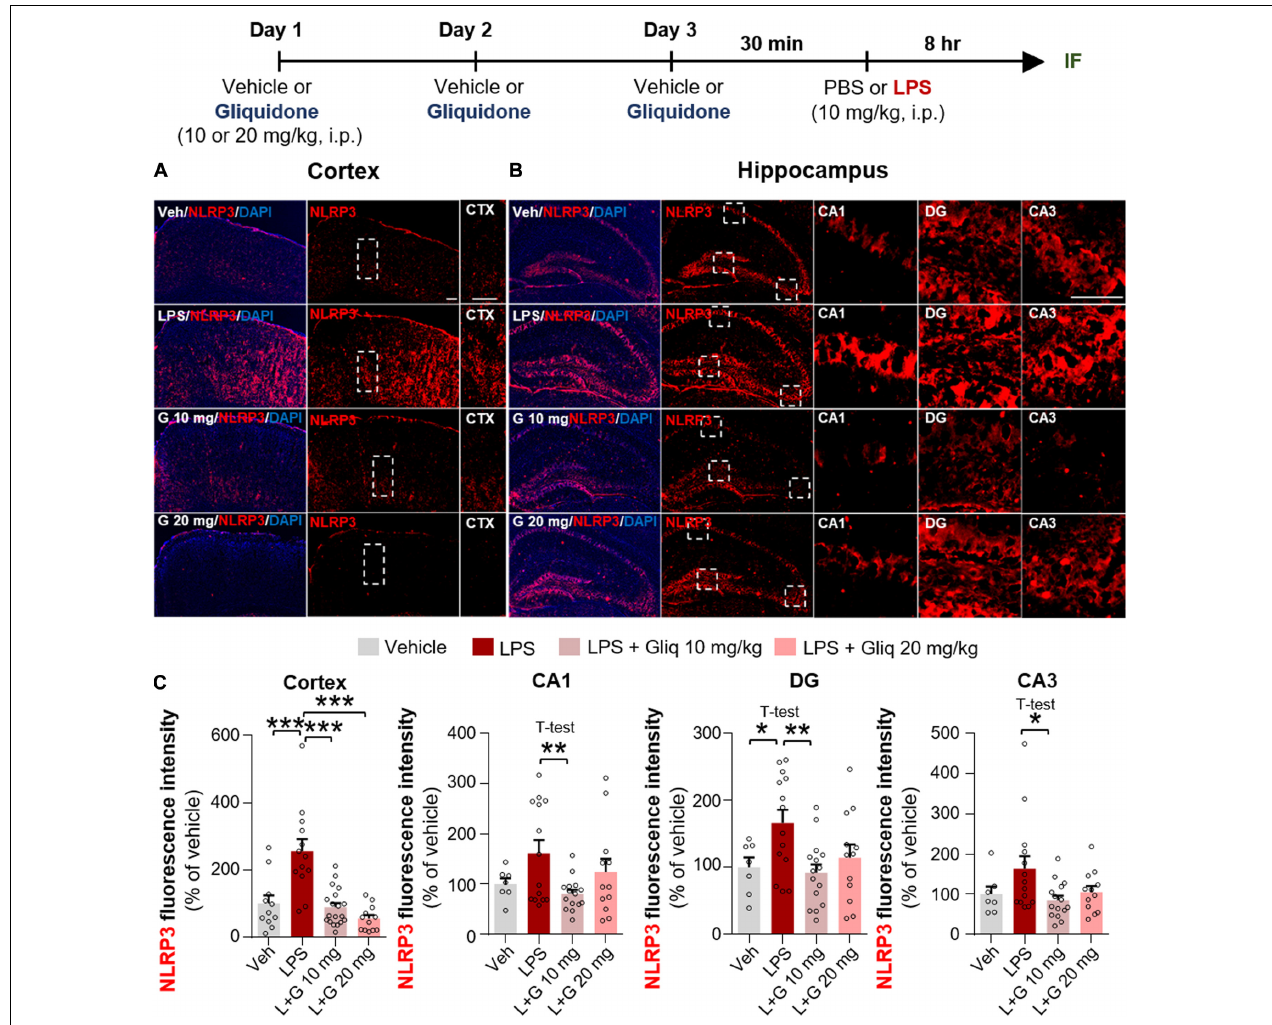
FIGURE 5 | Gliquidone eliminates the LPS-mediated increase in NLRP3 inflammasome levels in the brain in C57BL6/N mice. (A,B) Immunofluorescence staining of NLRP3 in brain slices from mice treated as shown at the top of the figure. (C) Quantification of the results in (A,B) ( n = 7–19 brain slices from 4 mice/group). * p < 0.05, ** p < 0.01, *** p < 0.001. Scale bar = 100 µ M.